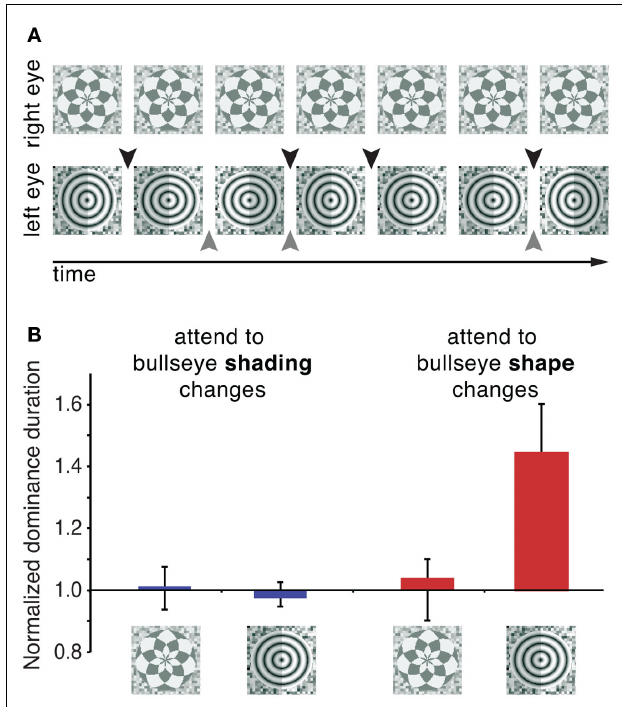
FIGURE 5 | Performing a demanding attentional task promotes selective attentional control over rivalry dynamics. (A) Stimuli used by Chong et al. (2005). One eye views a control stimulus (a radial checkerboard), while the other eye is shown a bullseye pattern. In two separate attentional tasks, observers were instructed to track either shape changes (black arrows) or shading changes (gray arrows) of the bullseye pattern.These tasks were demanding and required sustained attention. For illustration purposes, the magnitudes of the shape and shading changes are greatly exaggerated. Results (B) indicate that completing a demanding task that directs attention toward a rival stimulus lengthens its average dominance duration. On the other hand, an equally demanding task where attention was directed to the same location in space but not to rival stimulus per se did not affect rivalry dynamics. Adopted with permission from Chong et al., 2005; ARVO ©